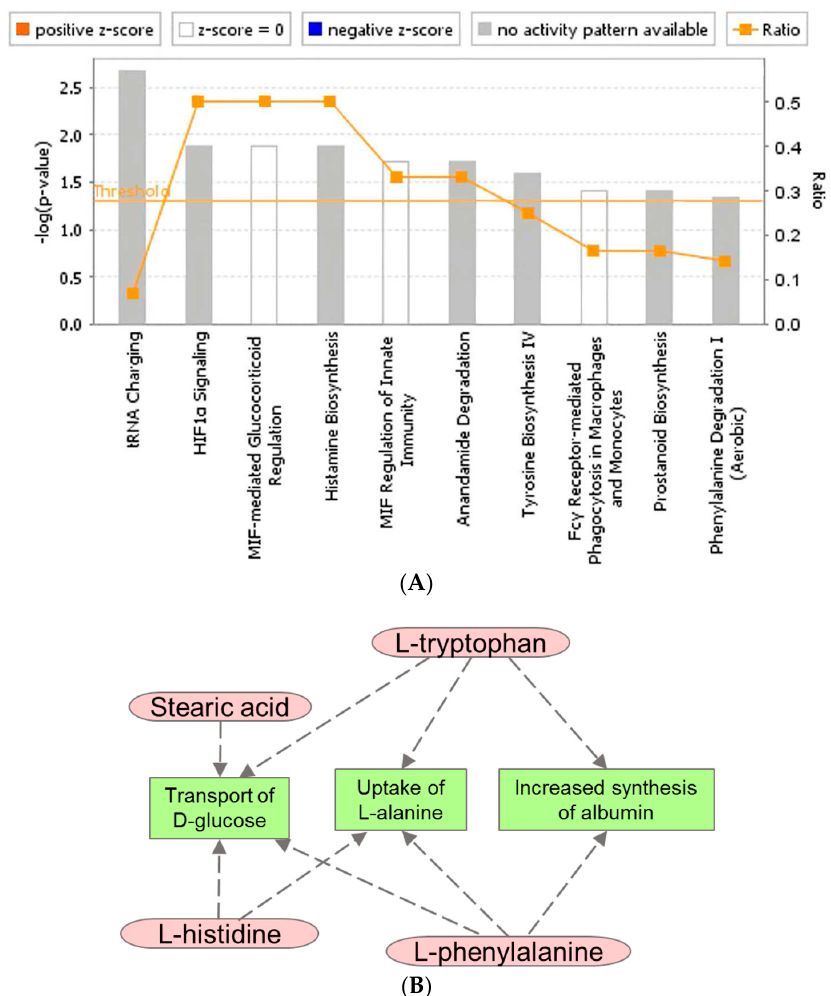
Figure 4. Ingenuity pathway analysis (IPA). Pathway enrichment analysis was performed on validated metabolites. IPA yielded information on 14 of the total validated metabolites. ( A ). Bar graph representing top canonical pathway implicated in these metabolites. ( B ) Network map visualizing representative implicated pathways of key validated biomarkers.